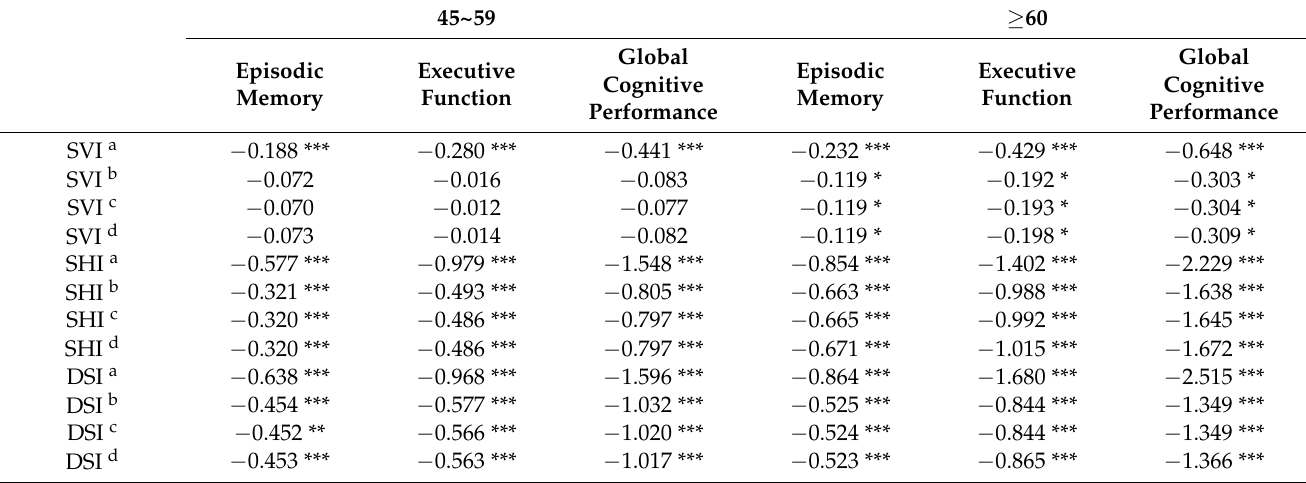
Table 3. Association between sensory impairments and cognitive decline, stratified by age.